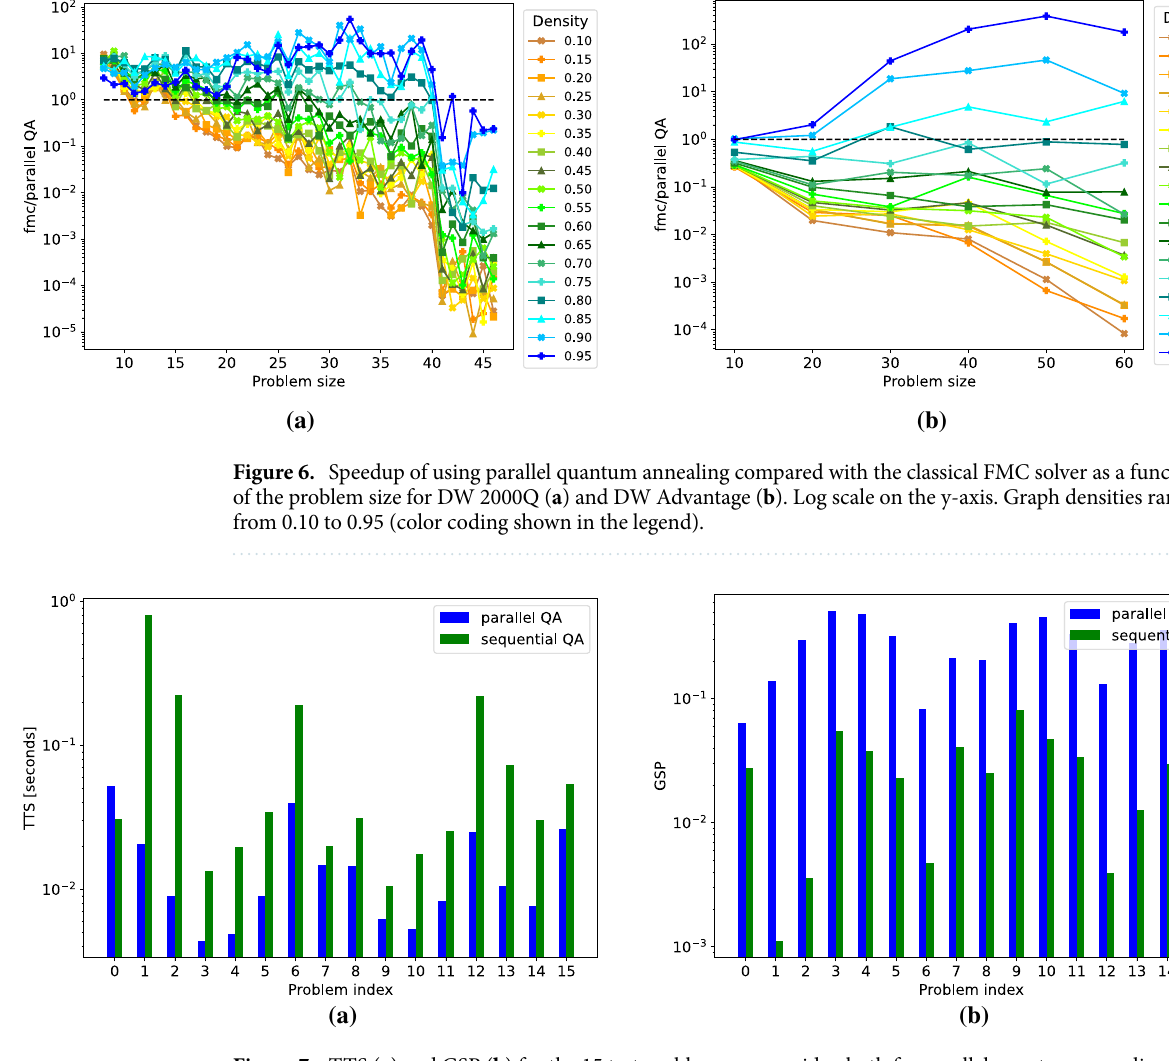
Figure 7. TTS ( a ) and GSP ( b ) for the 15 test problems we consider, both for parallel quantum annealing (blue) and sequential quantum annealing (green). Log scale on the